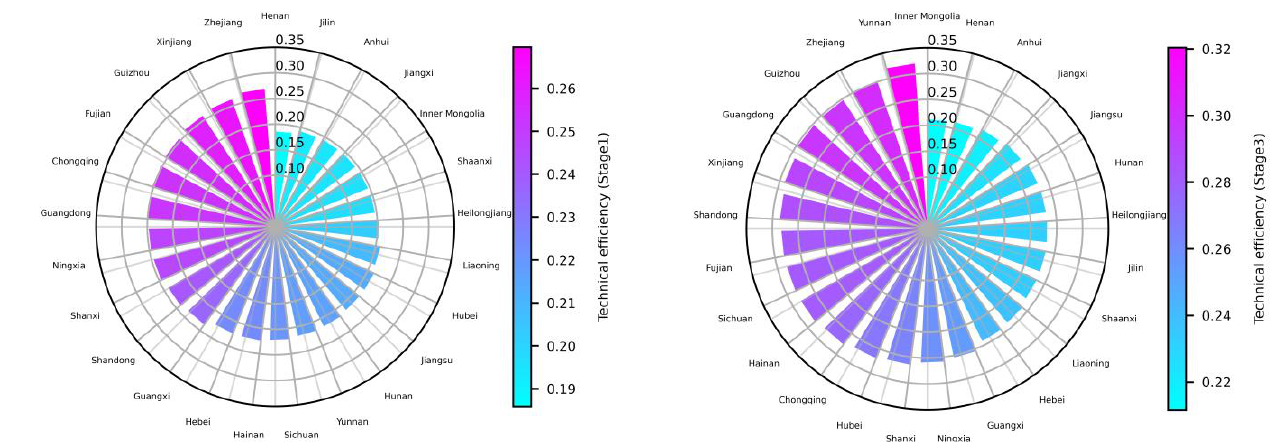
Figure 3. Technical efficiency values of state-owned forest farms in China (the two figures are the efficiency values of the first and third stages, respectively).